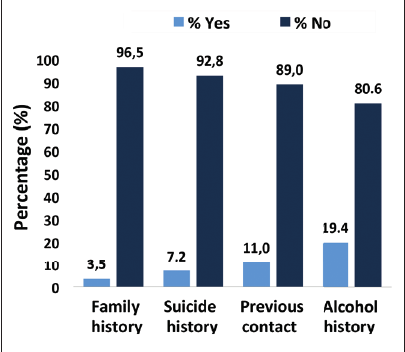
Fig. 1. Family history and previous contact with psychological services. Fig. 2 represents the personality profiles of the participants, including clinical patterns, severe personality pathology, clinical syndromes and severe syndromes, categorised as per the inventory in terms of rates of the modifier scales (disclosure, debasement and desirability). Six profiles were invalid. With regard to the modifier scales, a BR>74 was evident in 61 (43.9%; 95% CI 35.6 - 52.2), 35 (25.2%; 95% CI 18.0 - 32.4) and 26 (18.7%; 95% CI 12.2 - 25.2) subjects for the x -, y - and z -scales, respectively (Fig. 2a).